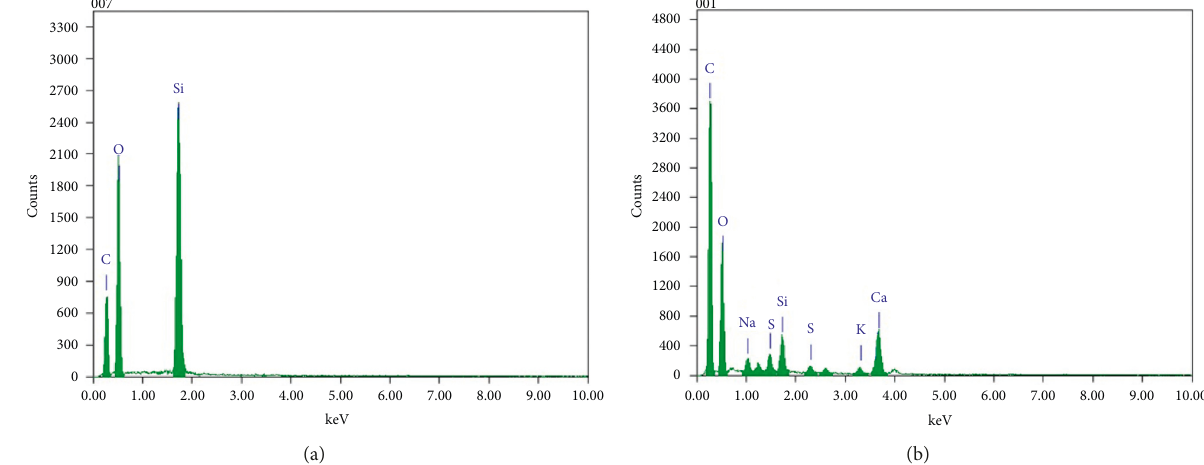
Figure 11: EDS analysis results. (a) AH-90; (b) GO-modified asphalt.